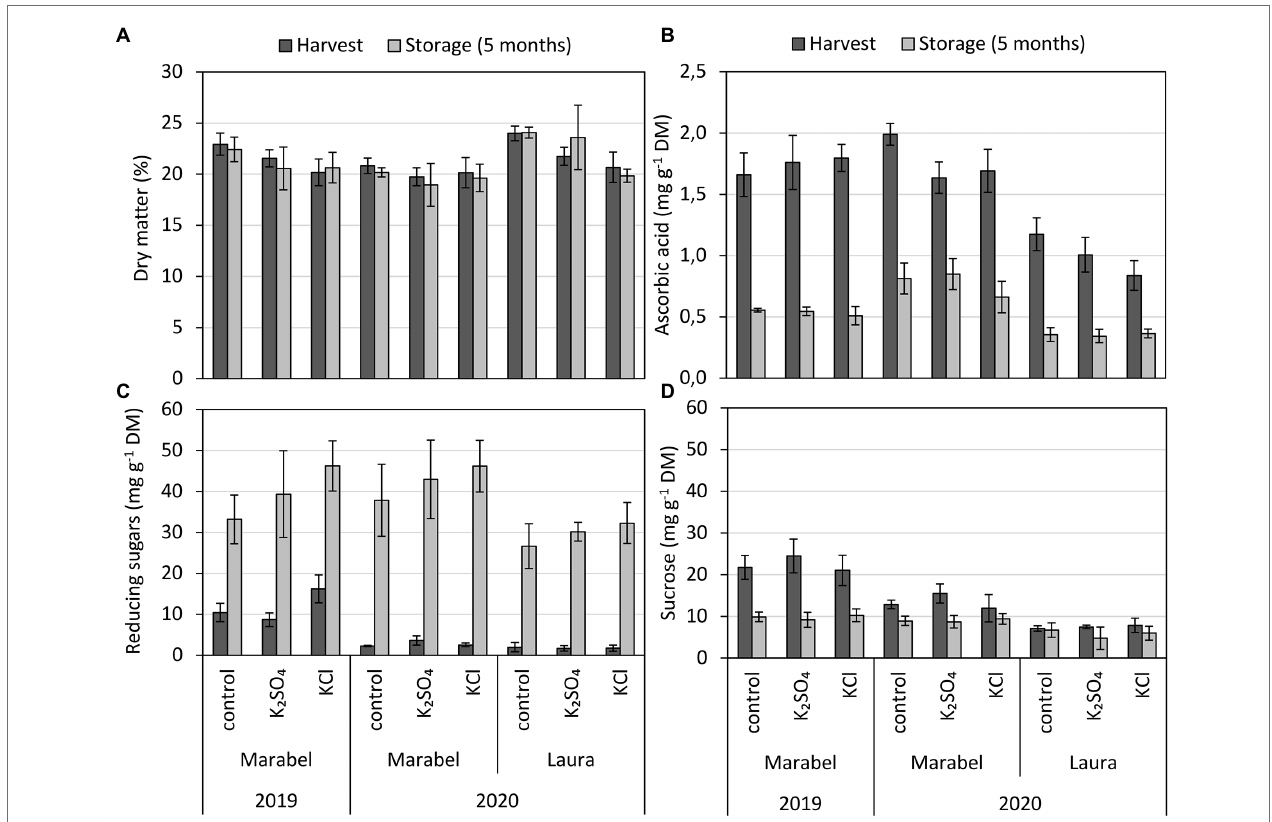
FIGURE 3 | (A) Dry matter, (B) ascorbic acid (flesh), (C) reducing sugar, and (D) sucrose concentration of entire tubers depending on year, cultivar, fertilisation form, and storage. Mean ± SD ( n = 4). *, **, and *** for p < 0.05, 0.01, and 0.001, respectively. n.s., Not significant. Effect of year considers differences of tubers after harvest between 2019 and 2020 for Marabel, cultivar effects describe differences between Laura and Marabel in 2020, and storage effects refer to data of both cultivars and both years. DM: fertilisation**, year**, cultivar***, storage n.s.; ascorbic acid: fertilisation**, year*; cultivar***; storage***; Red. sugars: